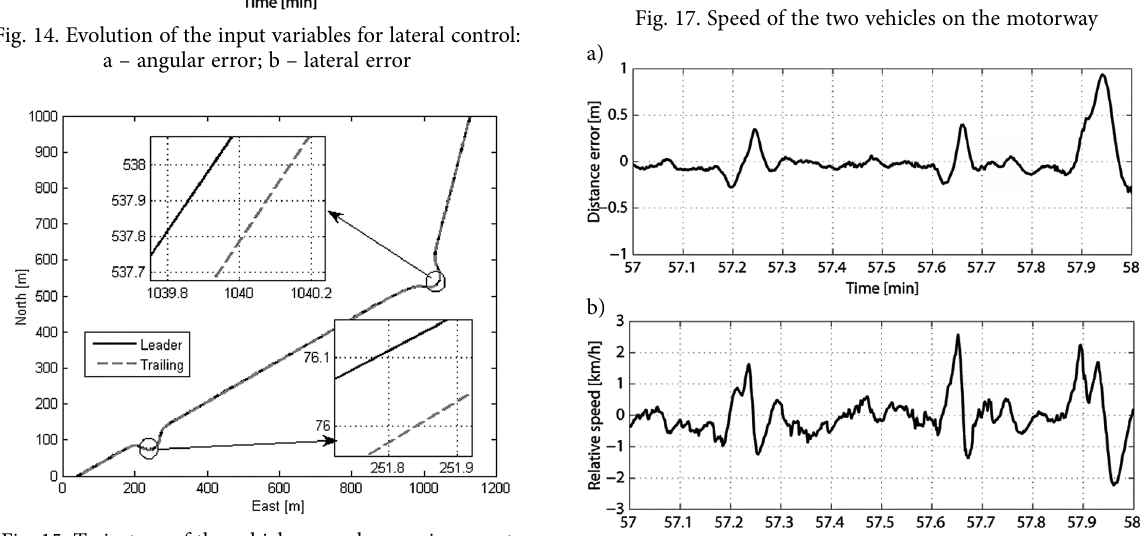
Fig. 15. Trajectory of the vehicles on urban environment